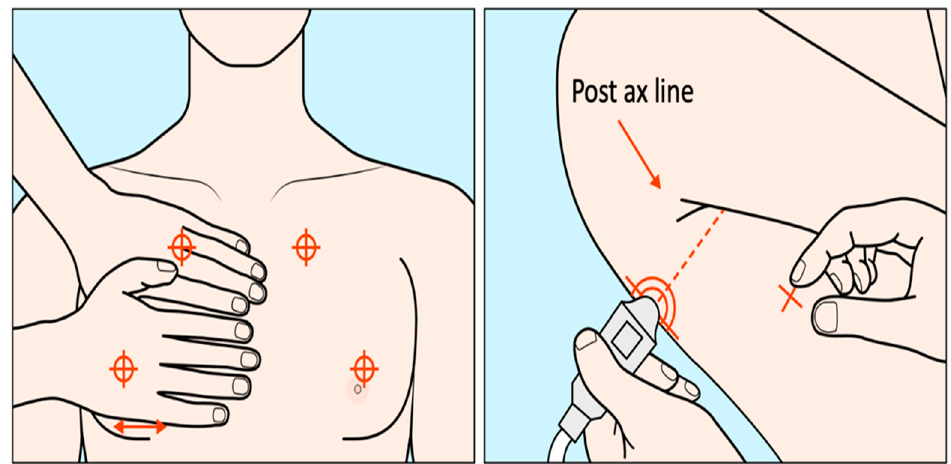
Figure 2. The three standard BLUE points are illustrated (two anterior and one posterior) [modified from [40]]. Two hands are placed on the front chest such that the upper hand touches the clavicle, and the upper anterior BLUE-point is in the middle of the upper hand, while the lower anterior BLUE-point is in the middle of the lower palm. The PLAPS-point is vertically at the posterior axillary line and horizontally at the same level of the lower anterior BLUE-point.